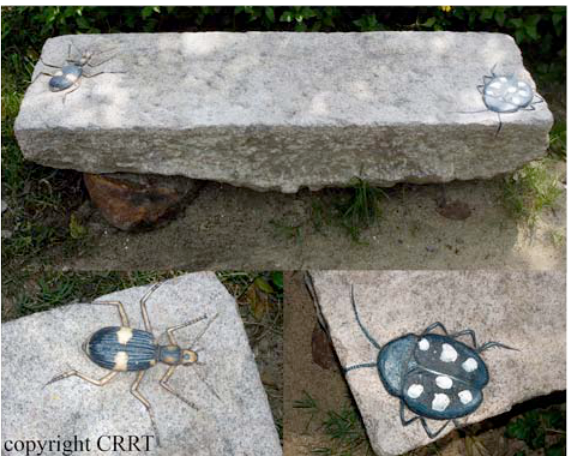
Image 10. An example of carved granite blocks used as benches. Species represented: Bombardier